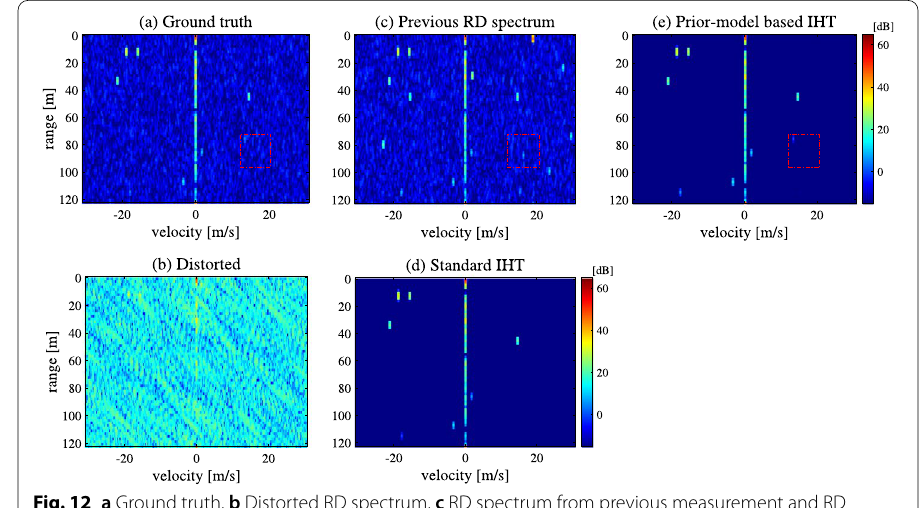
Fig. 12 a Ground truth, b Distorted RD spectrum, c RD spectrum from previous measurement and RD spectra recovered by d Standard IHT and e